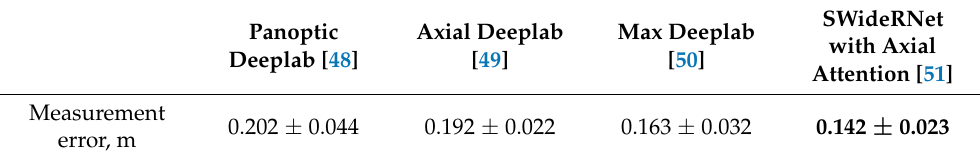
Table 2. Error values for measuring distances between objects on the scene of an